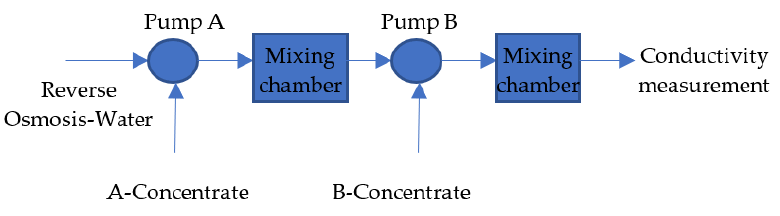
Figure 1. Simplified schematic diagram of fluid preparation.